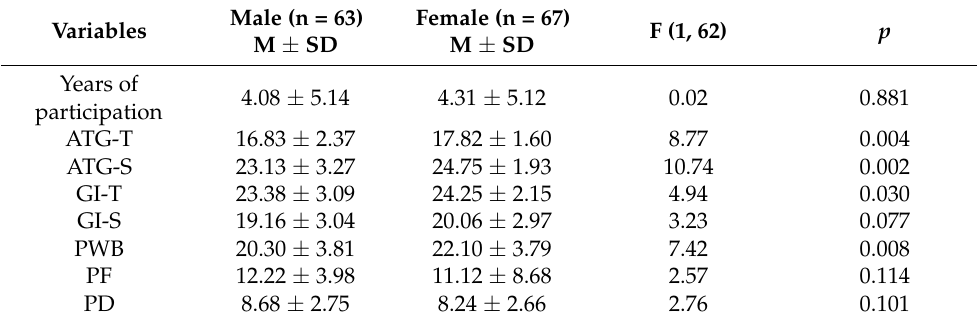
Table 4. Results of Repeated Measures ANOVA in different genders (N = 63 + 67). Male (n = 63) Variables M ± SD Years of participation